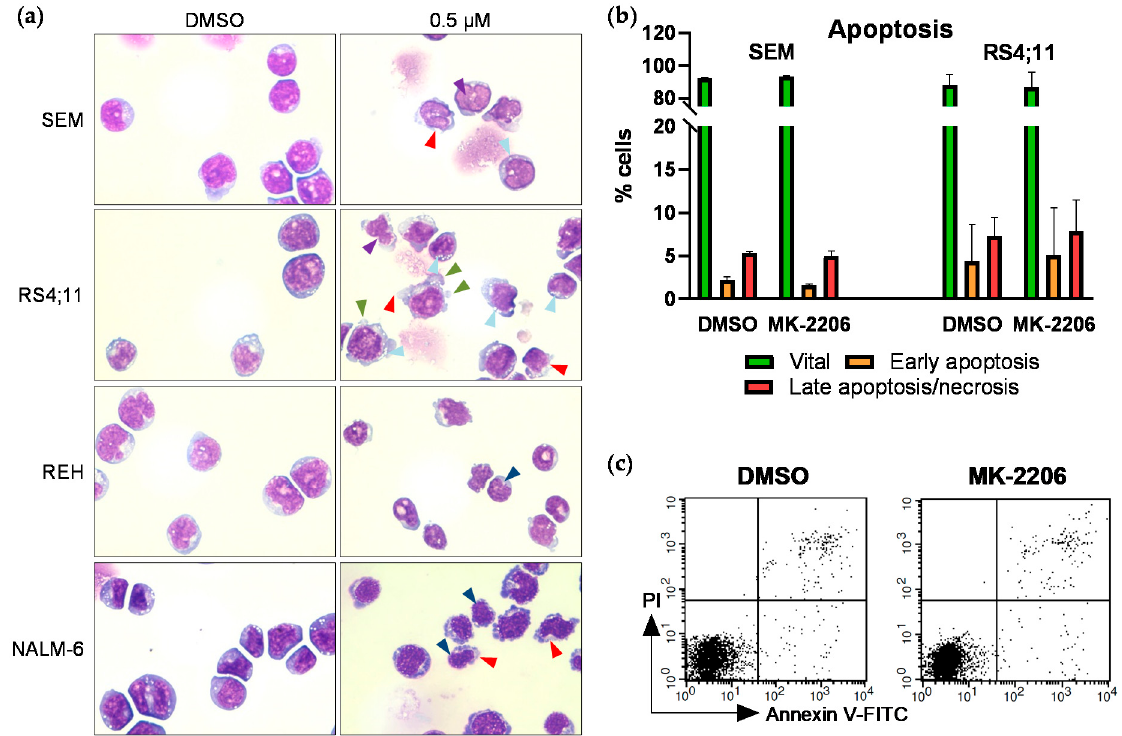
Figure 3. Effects of MK-2206 on cell morphology and apoptosis induction. ( a ) Cells were incubated with increasing concentrations for 72 h. Cytospins were prepared and Pappenheim stained. Representative images of all cell lines treated with 0.5 µM MK-2206, 100-fold magnification. Images were acquired using the EVOS xl core microscope (Nikon). Red arrows: disintegrating cell membrane; light blue arrows: vacuolization; purple arrows: nuclear fragmentation; green arrows: cytoplasmic blebs; dark blue arrows: karyopyknosis. ( b ) SEM and RS4;11 cells were incubated with 0.25 µM MK-2206 for 72 h and subsequently stained with annexin V-FITC and PI for apoptosis analysis by flow cytometry. Cells positive for annexin V and negative for PI are indicated as early apoptotic whereas cells positive for both markers are considered late apoptotic/necrotic. ( c ) Exemplary dot plots of flow cytometric apoptosis determination in SEM cells.